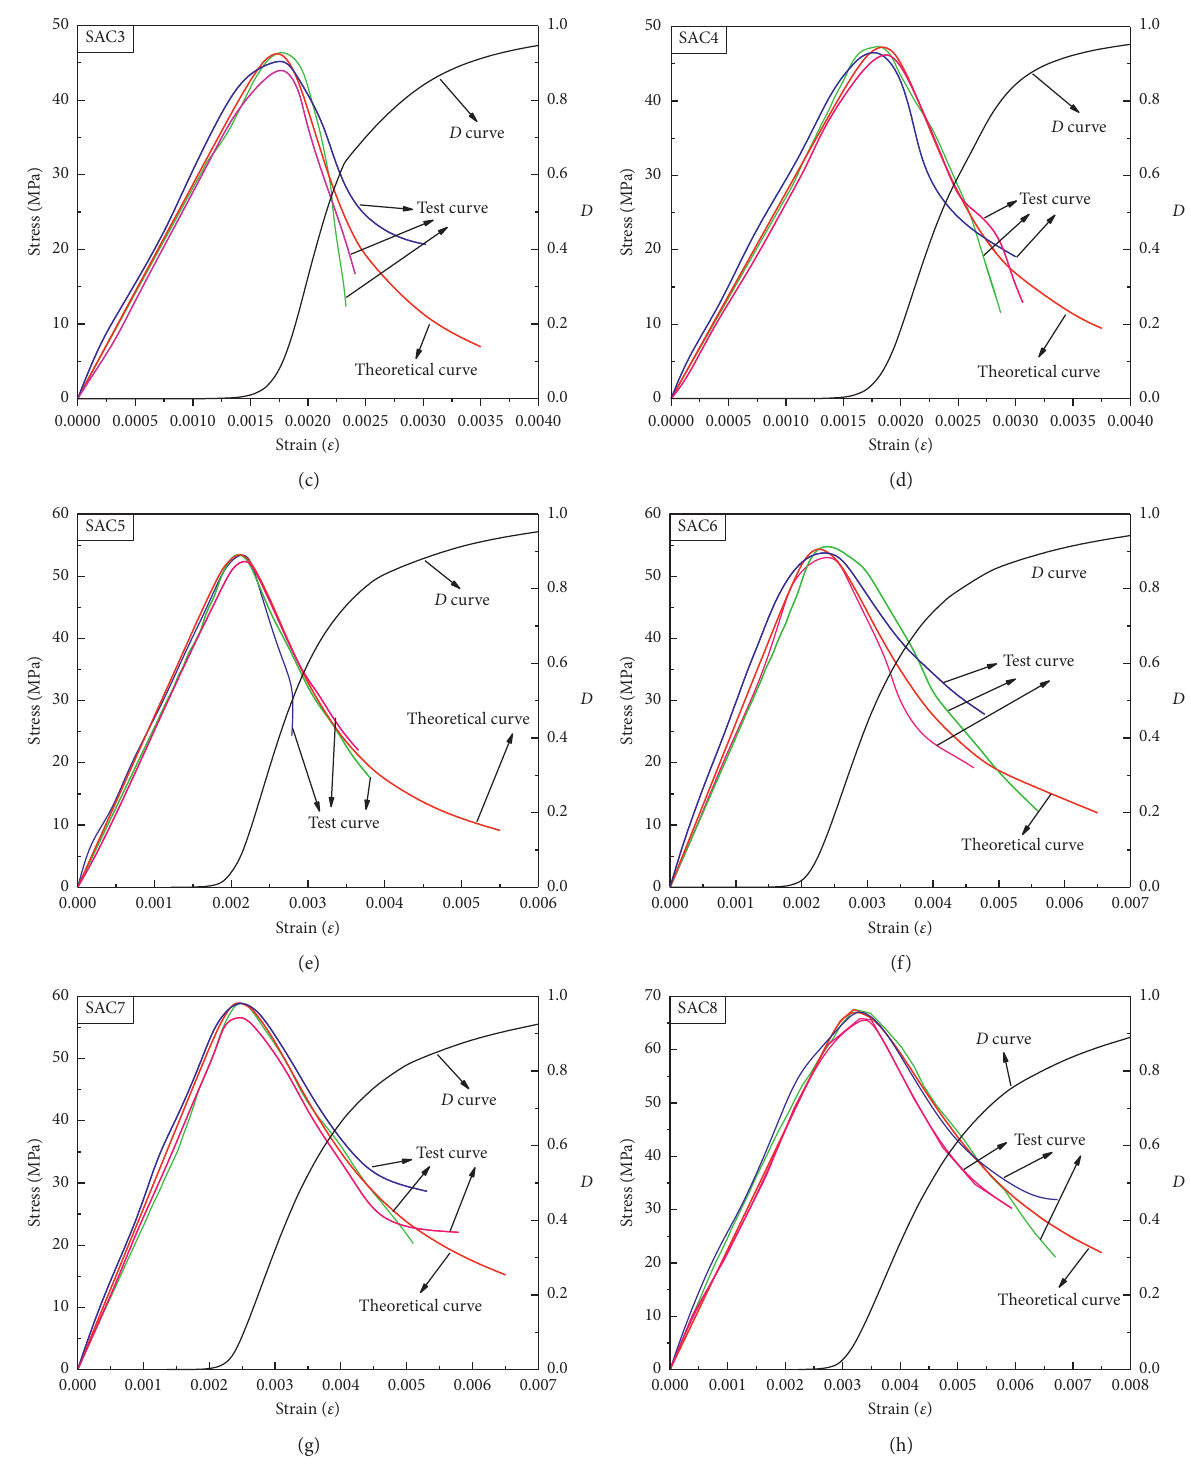
Figure 9: Comparison of experimental stress-strain curves for (a) SAC1; (b) SAC2; (c) SAC3; (d) SAC4; (e) SAC5; (f) SAC6; (g) SAC7; (h) SAC8 with the theoretical constitutive